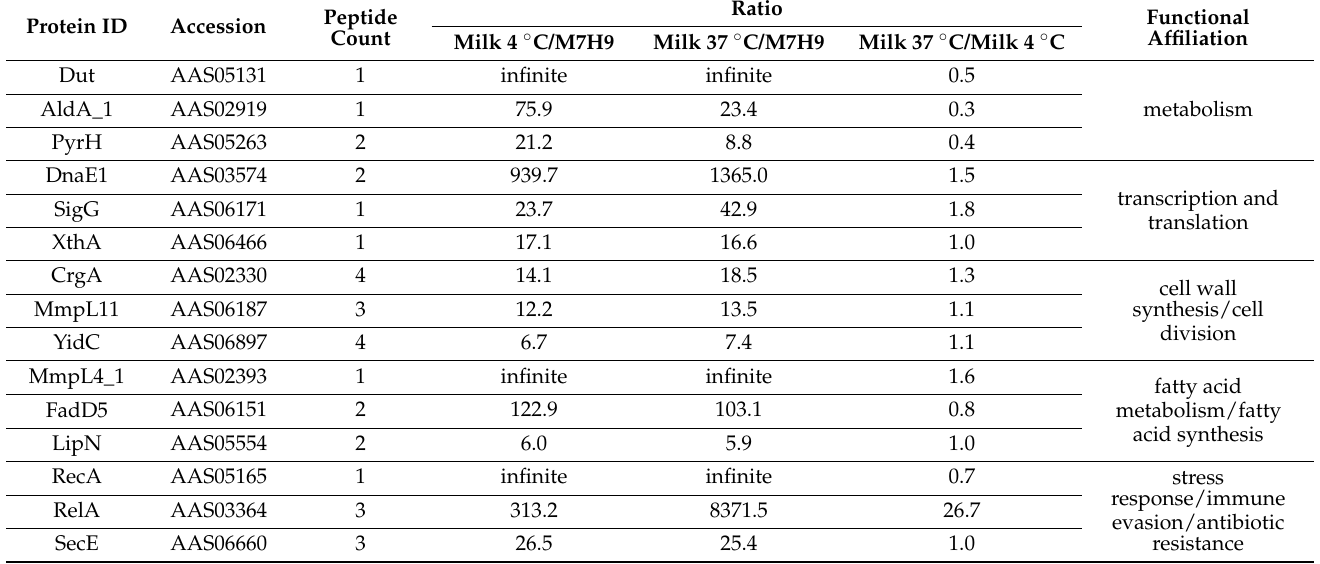
Figure 3. Functional affiliation of higher abundant MAP proteins in milk. The proteins fivefold higher in abundance in both milk at 37 ◦ C and 4 ◦ C compared to M7H9 broth can be functionally assigned to 32% metabolism (blue), 19% transcription and translation (pink), 19% stress response/immune evasion/antibiotic resistance (green), 17% each fatty acid metabolism/fatty acid synthesis (gray), and 13% cell wall synthesis/cell division (yellow). Table 1. Selection of differentially higher abundant MAP proteins in milk assigned to functional